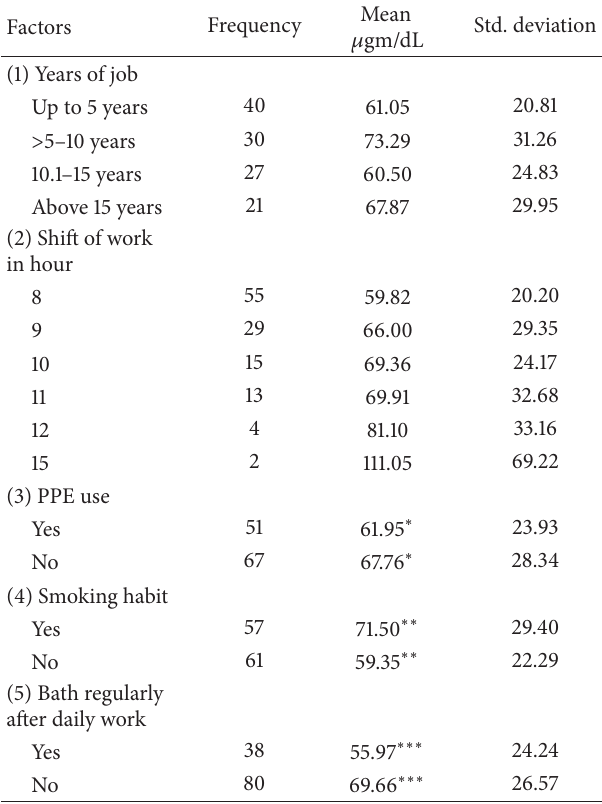
Table 2: Blood lead level of respondents according to years of job, daily working hour, and personal